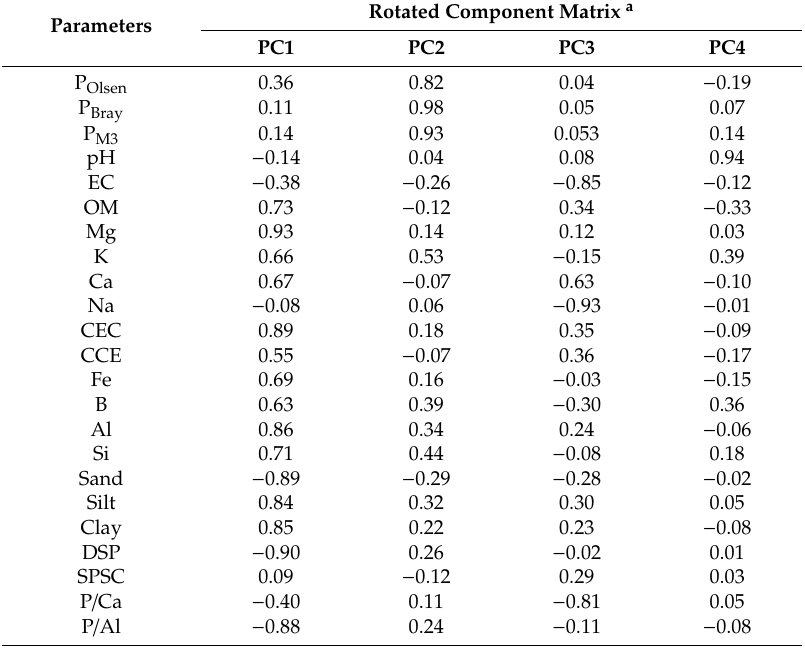
Table 5. Total variance explained and rotated component matrix (four principal components selected) for P